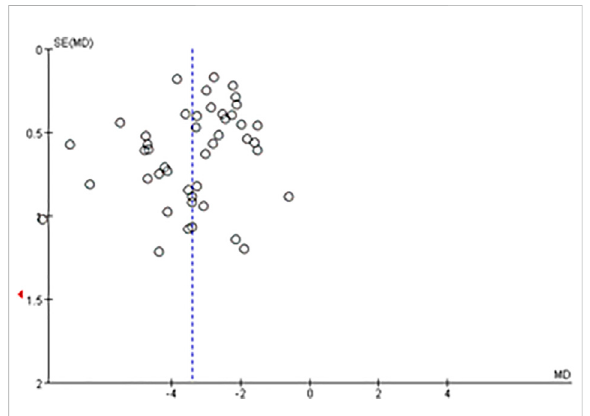
FIGURE 8 Funnel plot for evaluating publication bias in the meta- analysis of NIHSS score at the end of treatment or follow-up (46